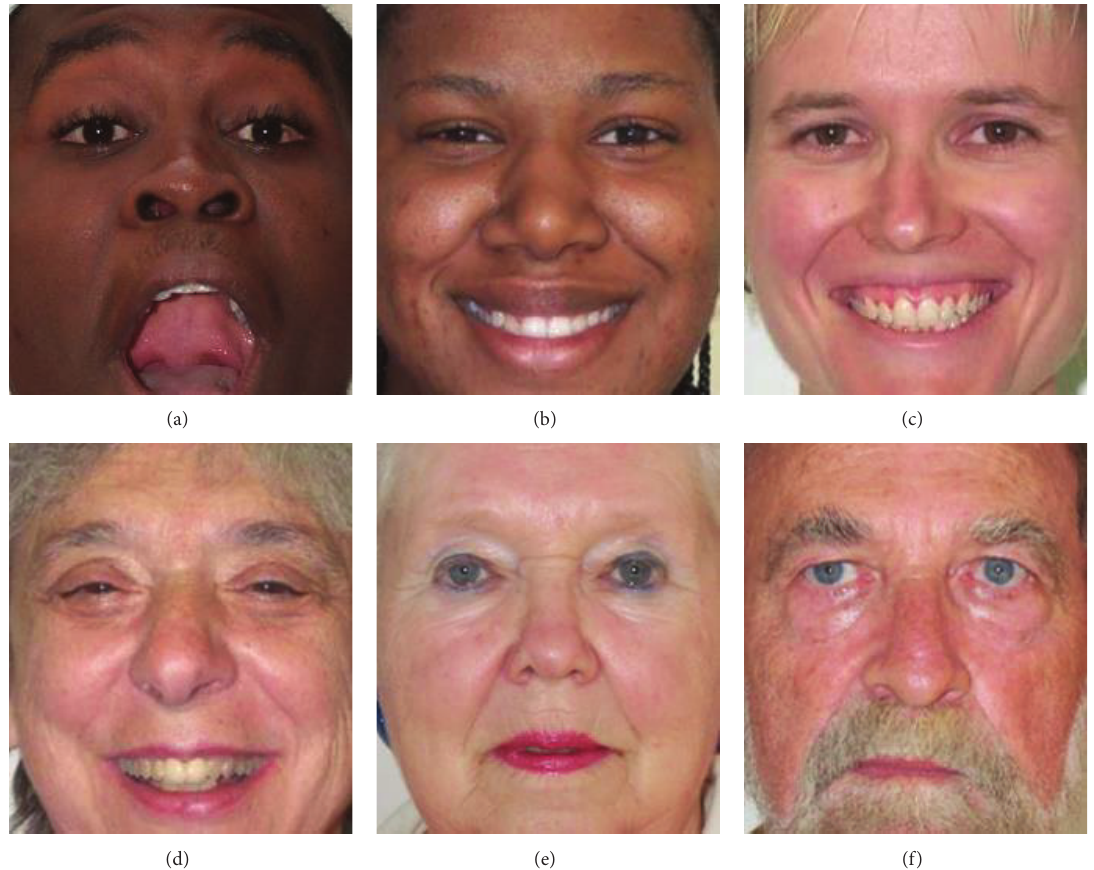
Figure 14: Examples of estimated and ground-truth ages with a large error: (a) ground-truth age of 19, estimated age of 30, (b) ground-truth age of 22, estimated age of 32, (c) ground-truth age of 29, estimated age of 37, (d) ground-truth age of 66, estimated age of 72, (e) ground-truth age of 75, estimated age of 68, and (f) ground-truth age of 64, estimated age of 74. Table 5: Comparison of MAEs with and without the preclassification of facial expression (unit: years old). Database Using only MLBP Using only Gabor filtering Proposed method Facial expression